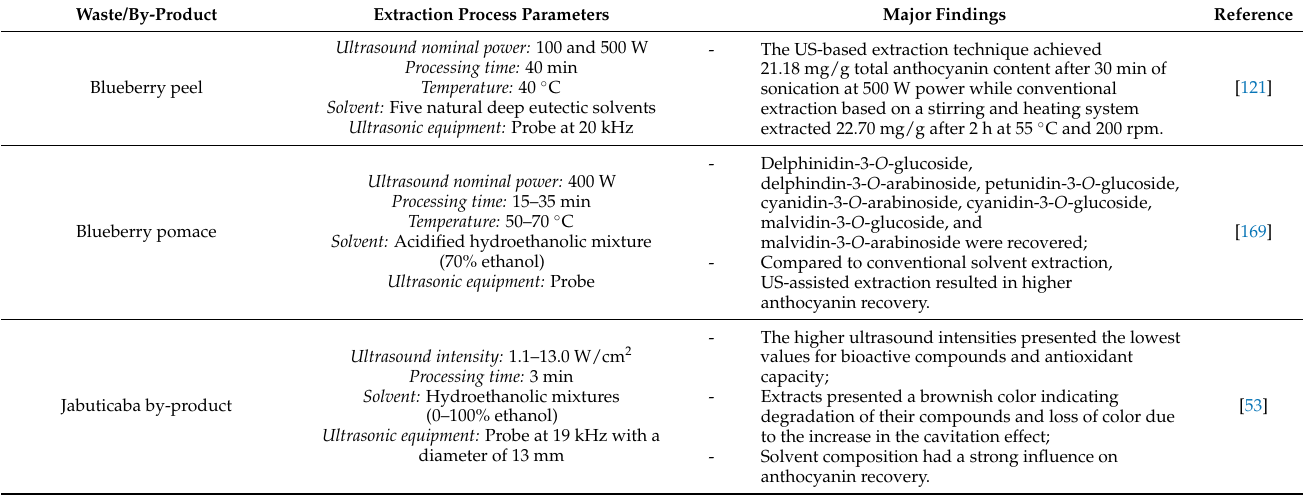
Table 4. Summary of the main recent findings showing the effects of the ultrasound (US) technology on anthocyanin extraction from agri-food